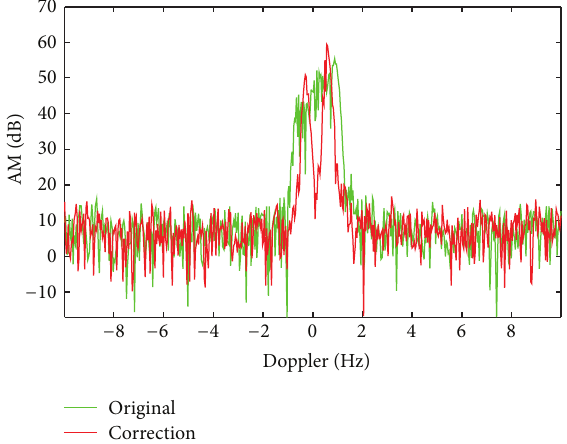
Figure 7: The decontamination results using S 2